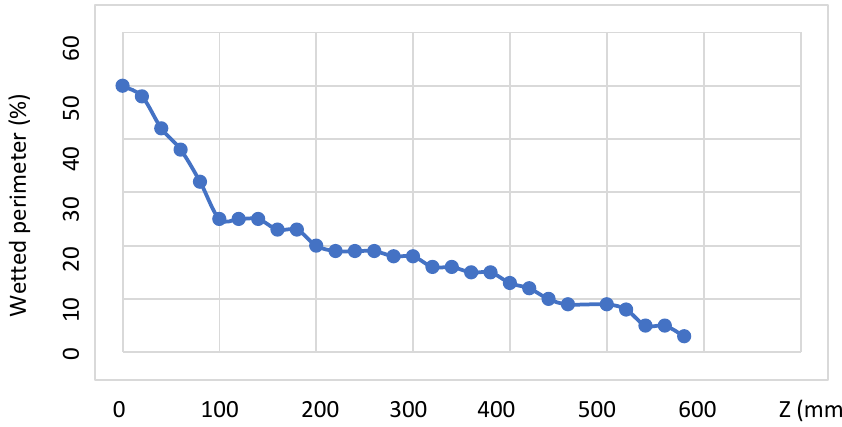
Figure 27. Wetted perimeter of the more viscous (green) polymer, as a function of the flow distance in the slit die of square cross-section (Adapted from Ref. [5]).